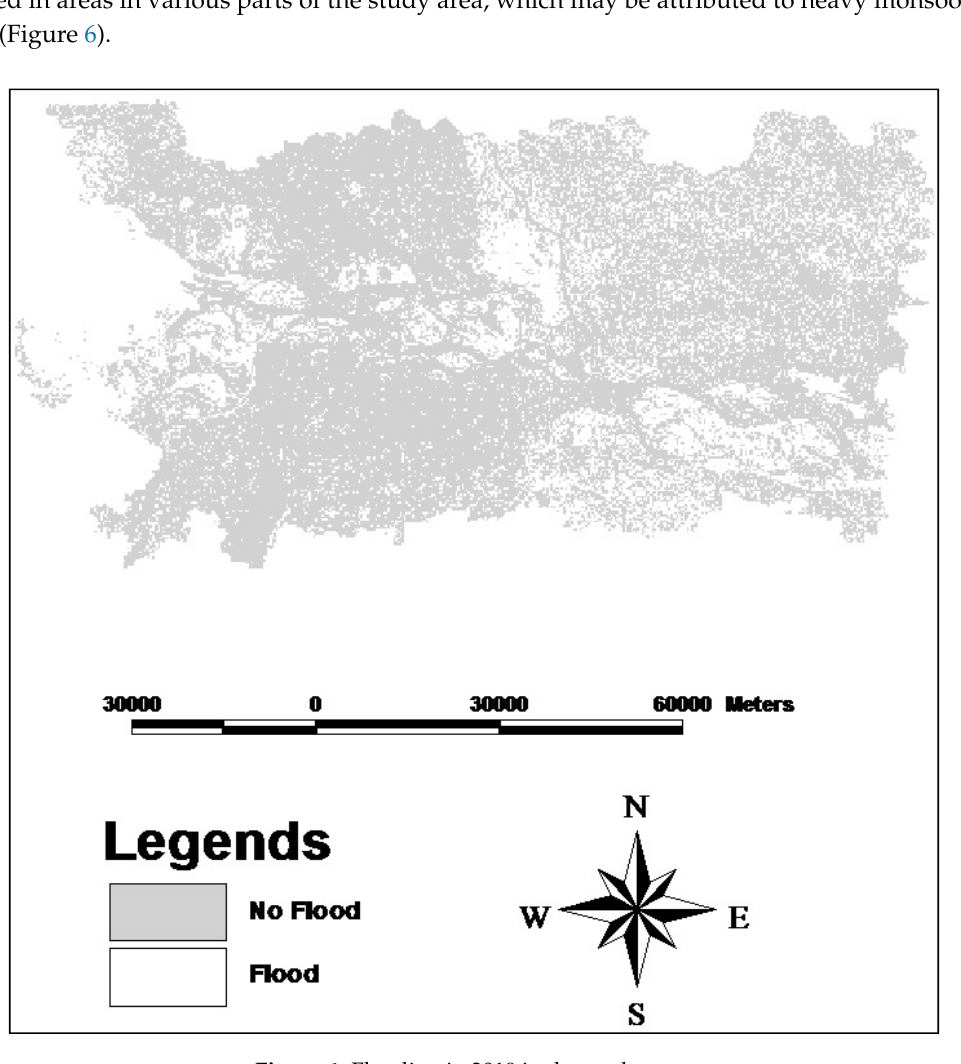
Figure 6. Flooding in 2019 in the study area.